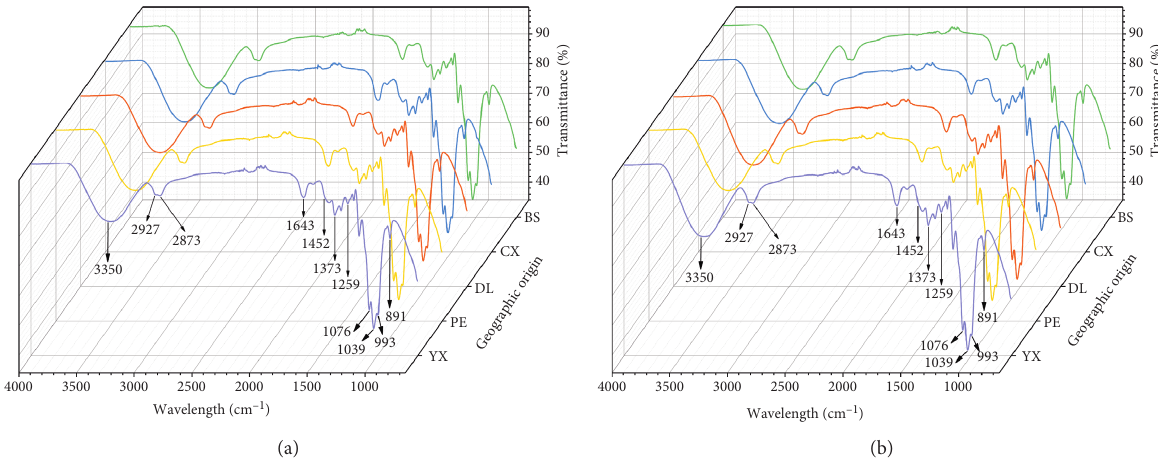
Figure 2: The original FTIR spectra of wild (a) and cultivated (b) M. cocos samples from five geographical